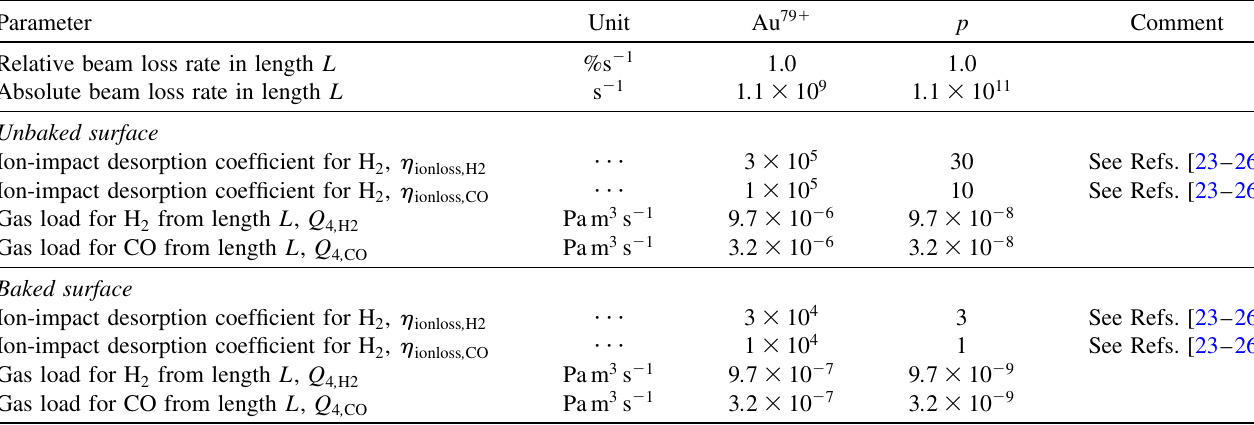
in the warm vacuum regions due to beam loss. 4